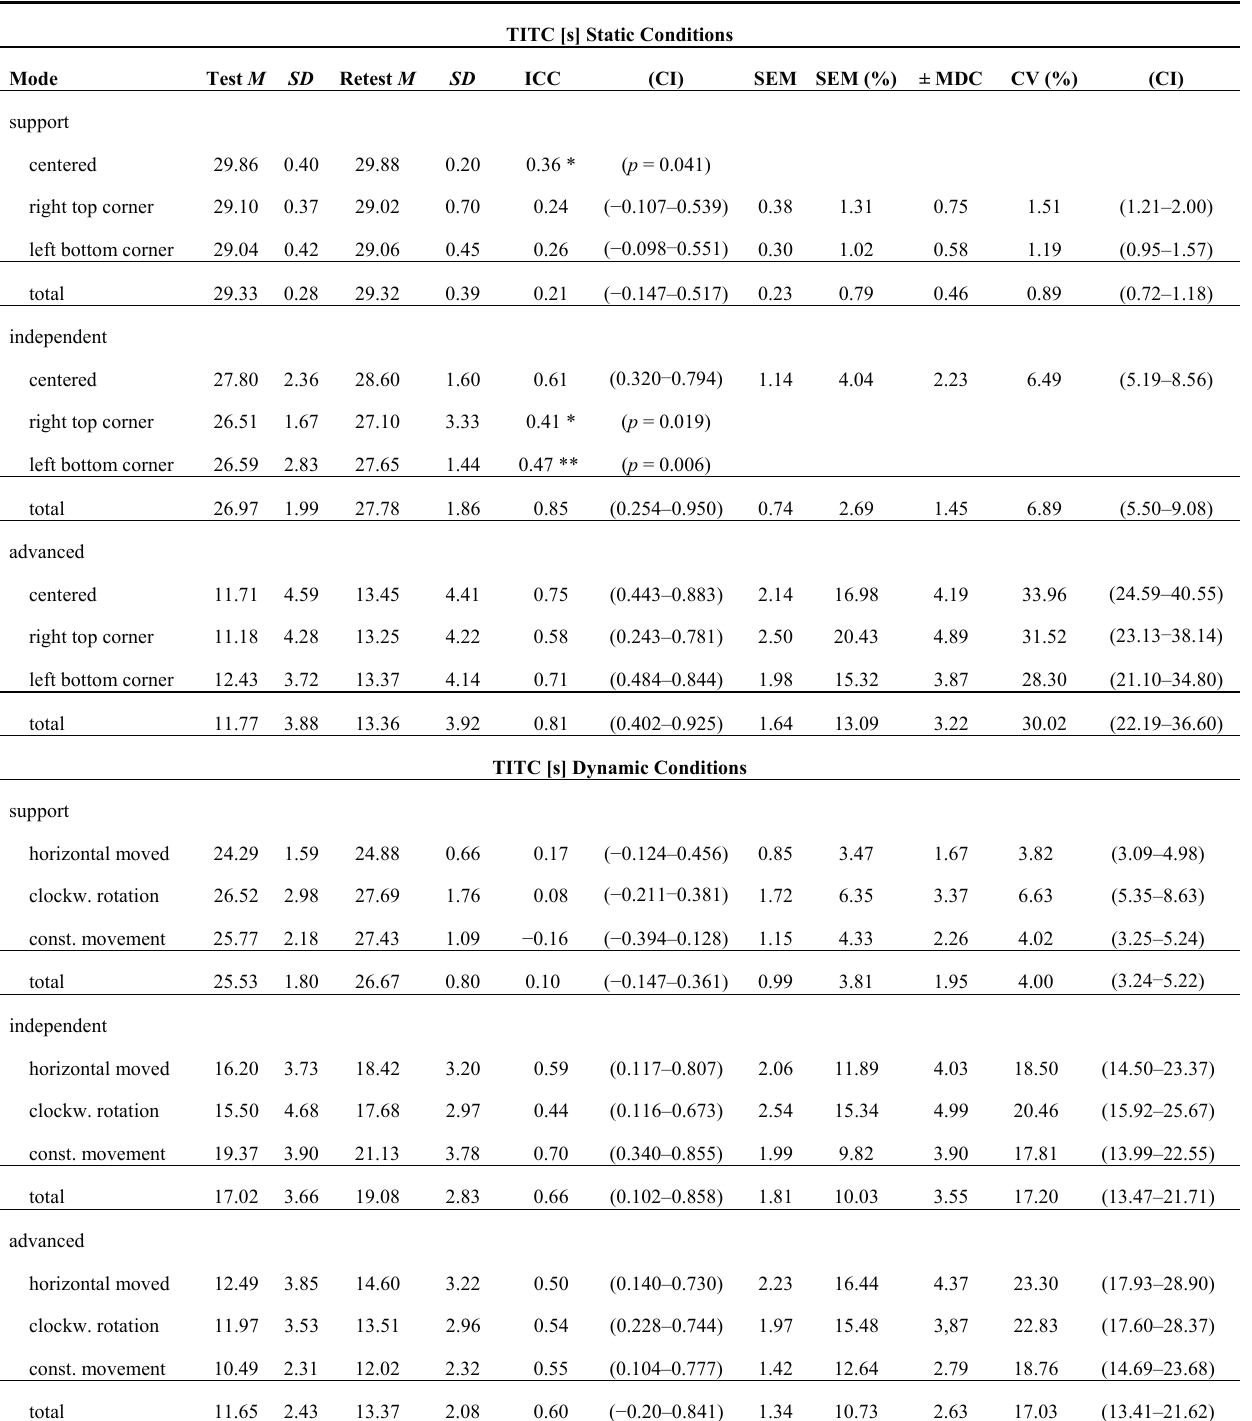
Table 2. Test-retest reliability analysis of the TITC in three different exercises and three different conditions of postural difficulty ( n =